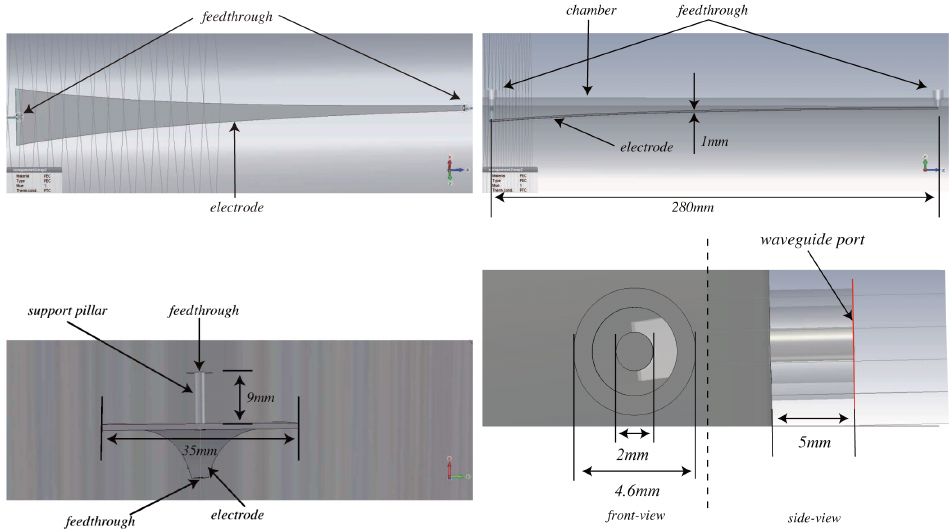
FIG. 3. The simulation model of the exponential electrode and the feedthrough. Top view (the upper left), side view (the upper right), and front view (the lower left) of the electrode. The lower-right figure shows the front and the side views of the feedthrough.